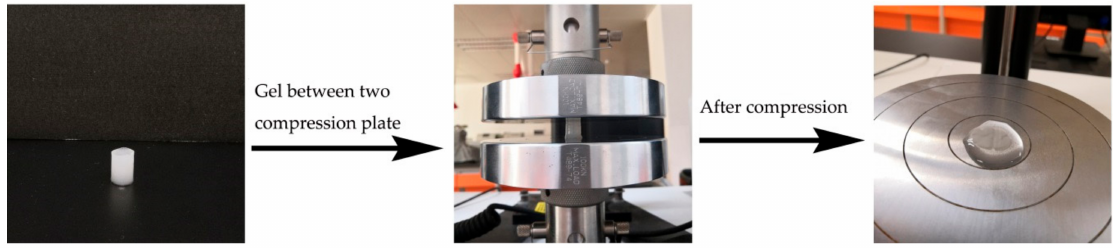
Figure 5. CNFs hydrogel for compression